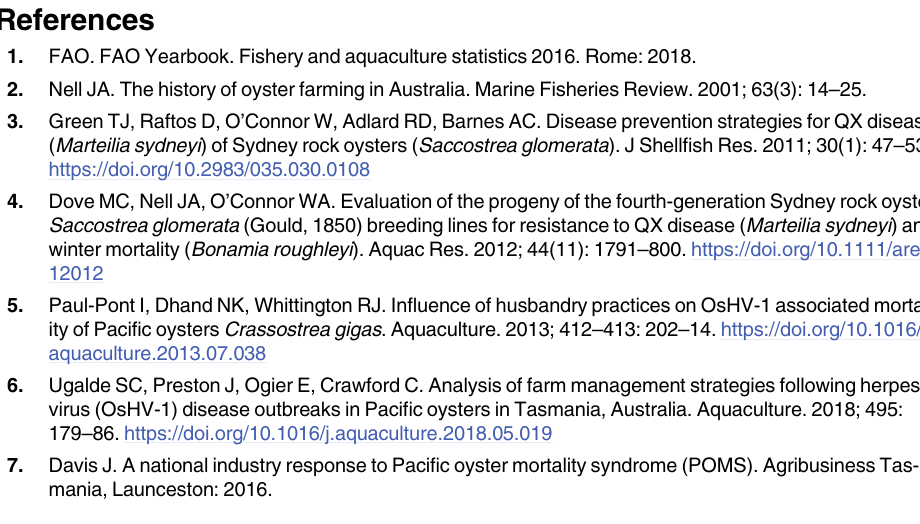
S1 Fig. Uncollapsed version of the phylogenetic tree presented in Fig 2. (PDF) S1 Table. Details of samples taken for gene expression